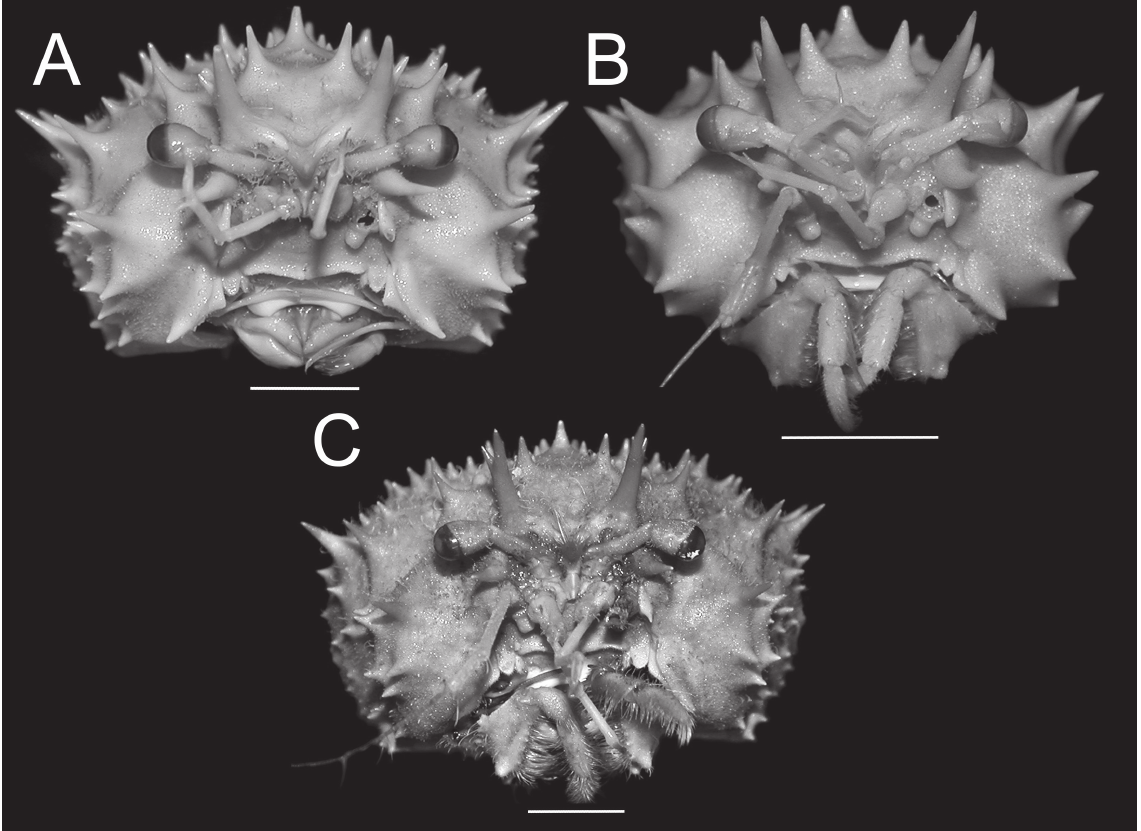
Fig. 4. Frontal view of cephalothorax. A . Moloha grandperrini Guinot & Richer de Forges, 1995. Holotype, ♂ (cl 46.5 mm, cw 39.0 mm) (NHM 1948.9.7.27), Maldives. B . Moloha alisae Guinot & Richer de Forges, 1995. Holotype, ♂ (cl 36.1 mm, cw 29.7 mm) (MNHN-IU-2008-11077), Seychelles. C . Moloha tumida sp. nov. Holotype, ♂ (cl 55.7 mm, cw 50.6 mm) (DABFUK), Kerala, India. Scale bars = 10